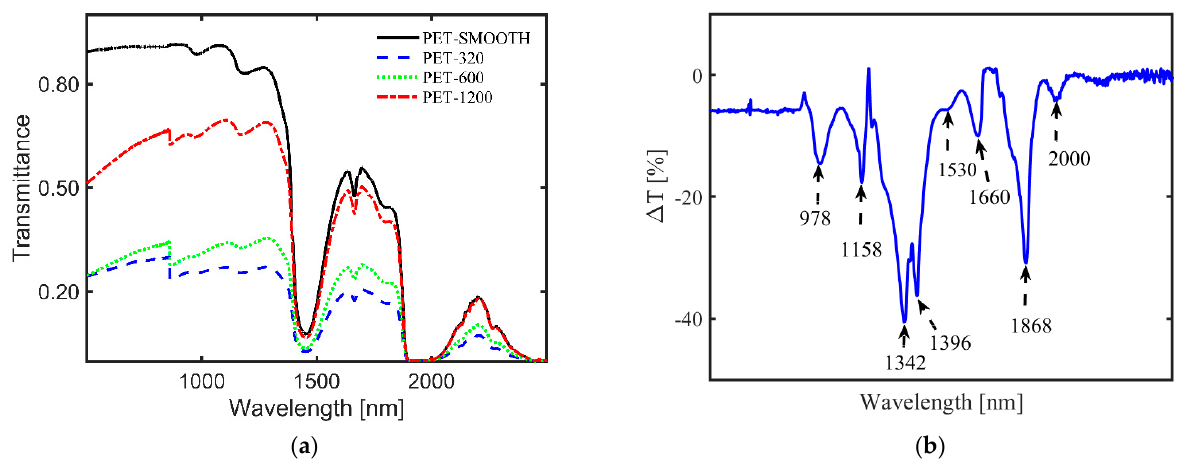
Figure 4. ( a ) Influence of surface roughness on the transmittance of film-type MPs, with a rough surface on both sides, in water [24]. MPs were prepared from polyethylene terephthalate (PET) plastic roughened with different sandpaper grits, 1200, 600, and 320, to achieve average surface roughness values of 0.34 µ m, 0.60 µ m, and 1.10 µ m, respectively. The transmittance of the MPs nonlinearly decreases with increasing average surface roughness over the whole spectral range. ( b ) Difference in transmittance ( ∆ T) between the pure ethanol only and ethanol-containing MPs from a real sludge sample [submitted elsewhere]. It allows the immediate authentication of characteristic peaks of certain plastics in an extremely complex environment: polystyrene (PS, λ = 1158 nm), polyethylene (PE, λ = 1396 nm), and polyethylene terephthalate (PET, λ = 1660